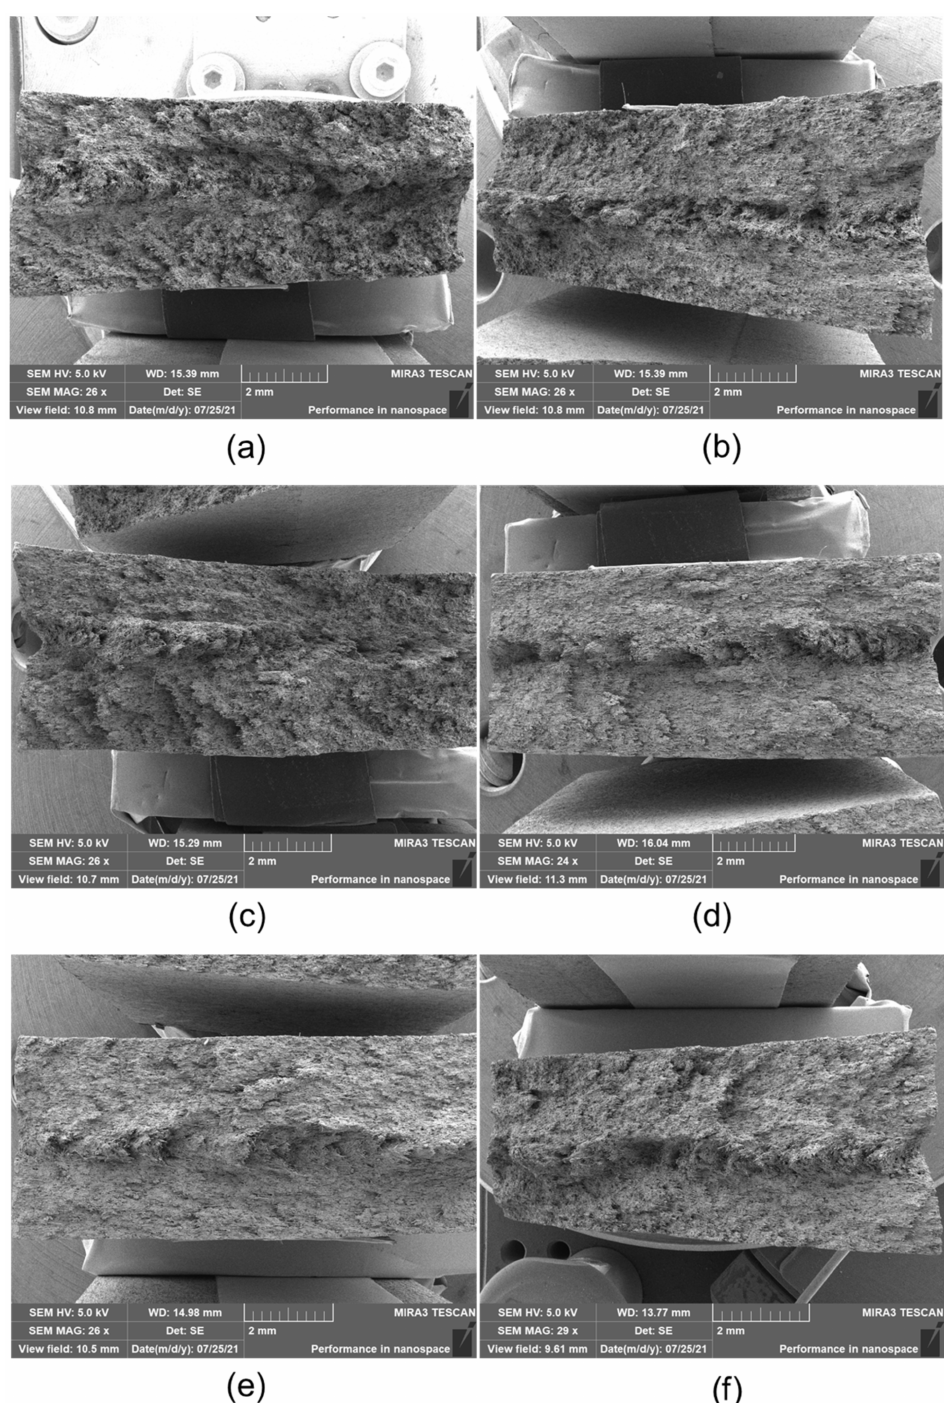
Figure 3. Fracture surface observations of the composite samples: ( a ) GF/PPS-0, ( b ) GF/PPS-85, ( c ) GF/PPS-100, ( d ) GF/PPS-115, ( e ) GF/PPS-130, ( f )